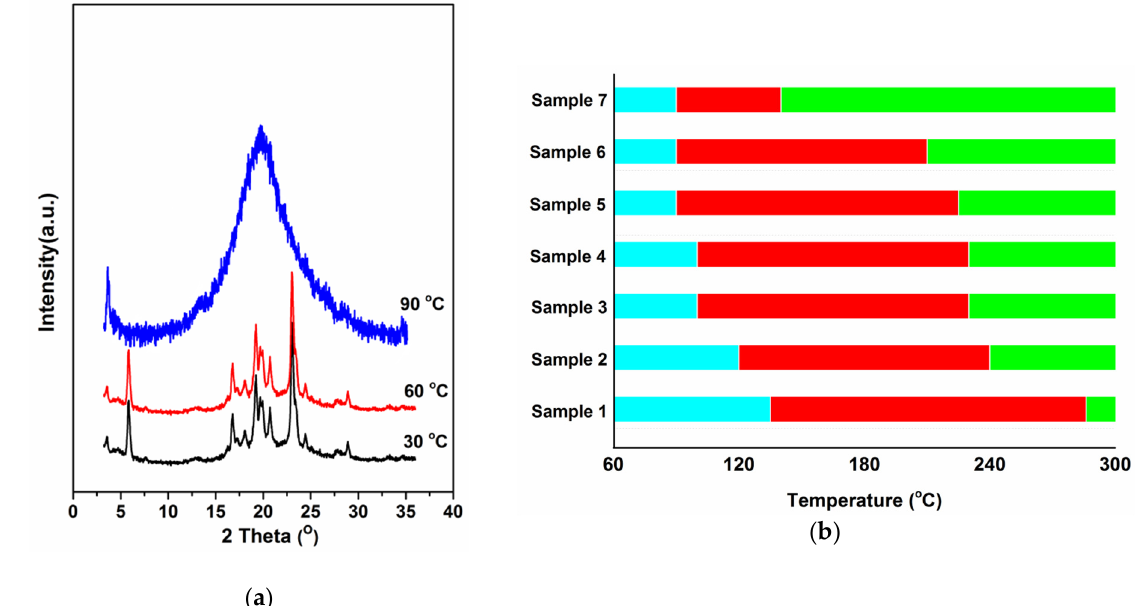
Figure 5. 1D WAXD patterns of sample 7 during heating process ( a ), and LC temperature range of samples 1–7 ( b ). Crystal phase (azure), smectic phase (red), and isotropic phase (green).